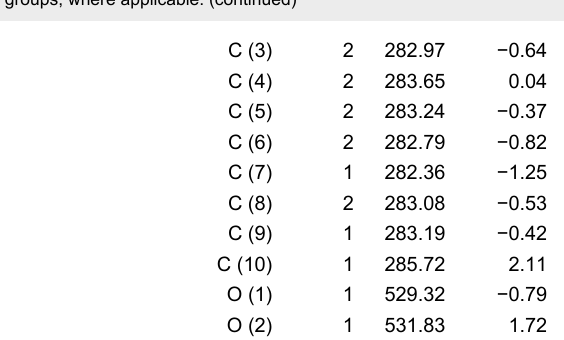
Table 3: Calculation results for the saturated single vacancy struc- tures. The columns show: system identifier; formation energy of the defect; target atom of the calculation (see Figure 3); number of target atoms; calculated 1s binding energy; C 1s BE shift with respect to the calculated C 1s energy of pristine graphene or the O 1s BE shift with respect to the calculated O 1s energy of epoxide/hydroxide functional groups, where applicable. (continued)